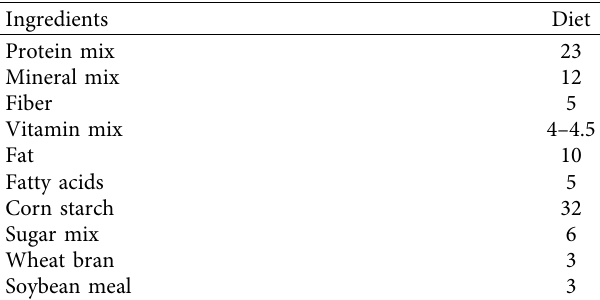
Table 1: Ingredient composition of the diets fed to the rats (g/